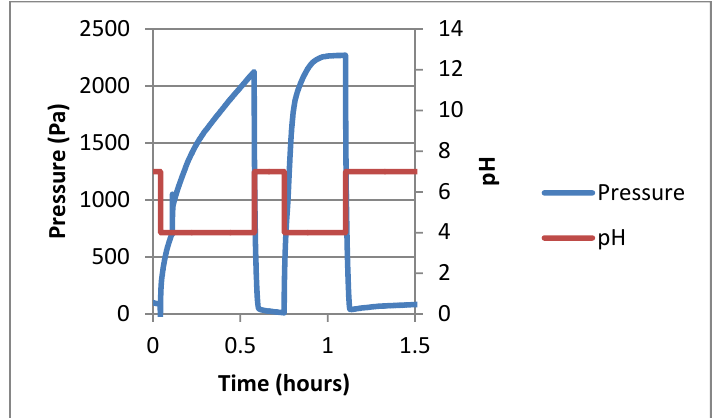
Figure 3. Representative data showing 2 cycles of the pH response from the Boss sensor from pH 4.0 to